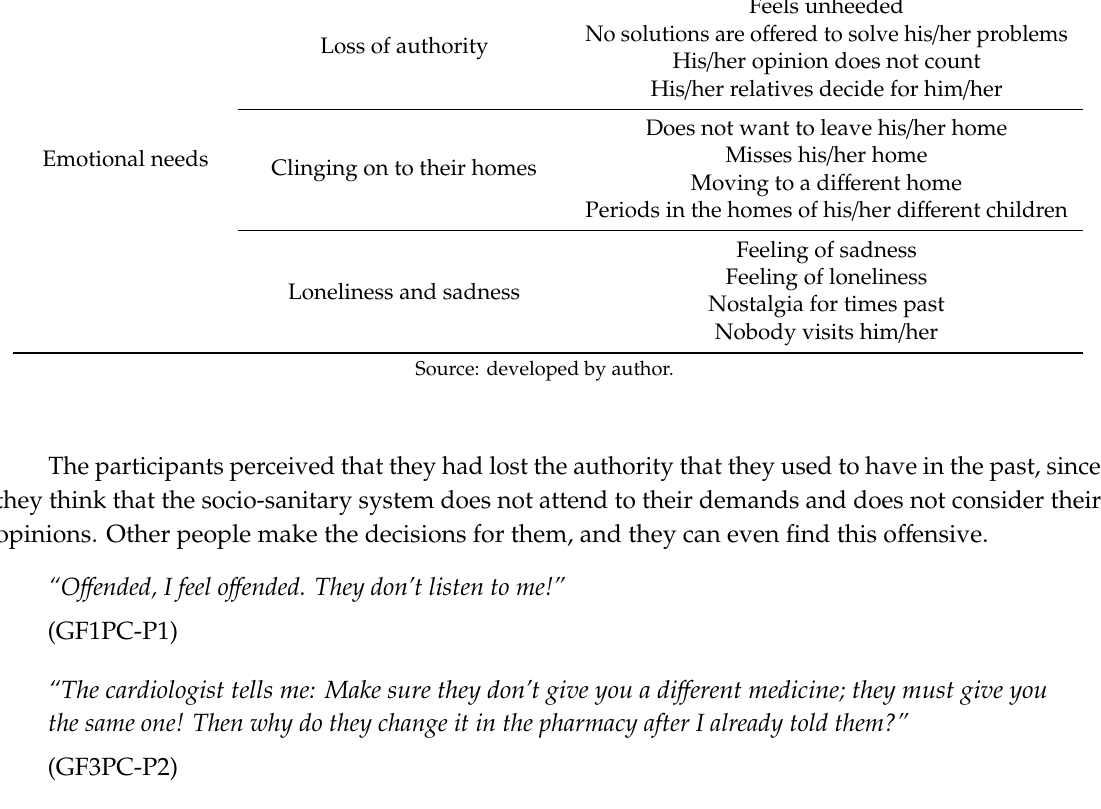
Table 4. Theme, subthemes, and codes related to the satisfaction of psychological needs of PCDD. Theme Subtheme Codes Feels unheeded No solutions are o ff ered to solve his / her problems Loss of authority His / her opinion does not count His / her relatives decide for him / her Does not want to leave his / her home Misses his / her home Emotional needs Clinging on to their homes Moving to a di ff erent home Periods in the homes of his / her di ff erent children Feeling of sadness Feeling of loneliness Loneliness and sadness Nostalgia for times past Nobody visits him /